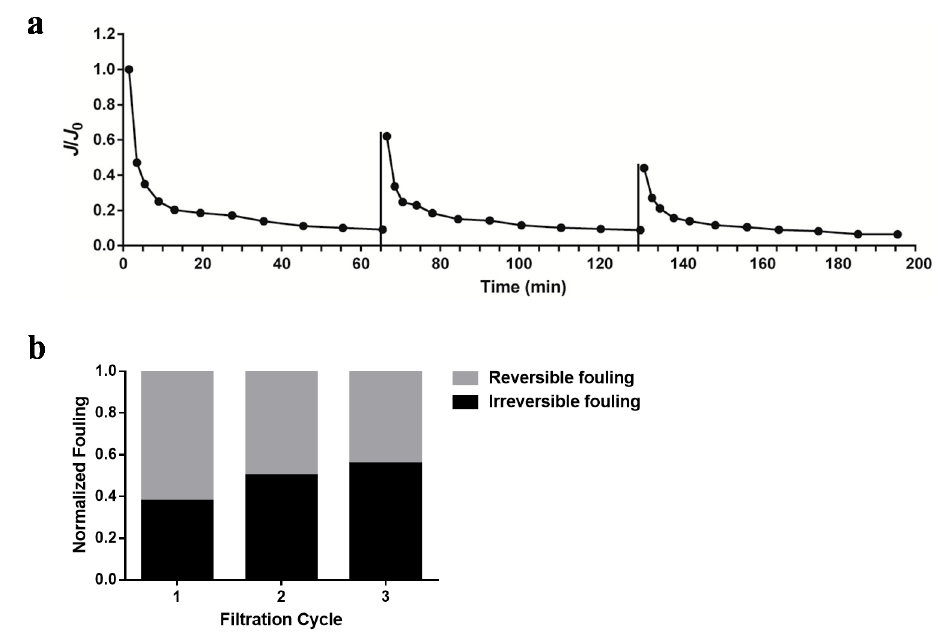
Figure 8. Flux decline ( a ) and reversibility ( b ) of fouling during UF filtration of Syn7942.